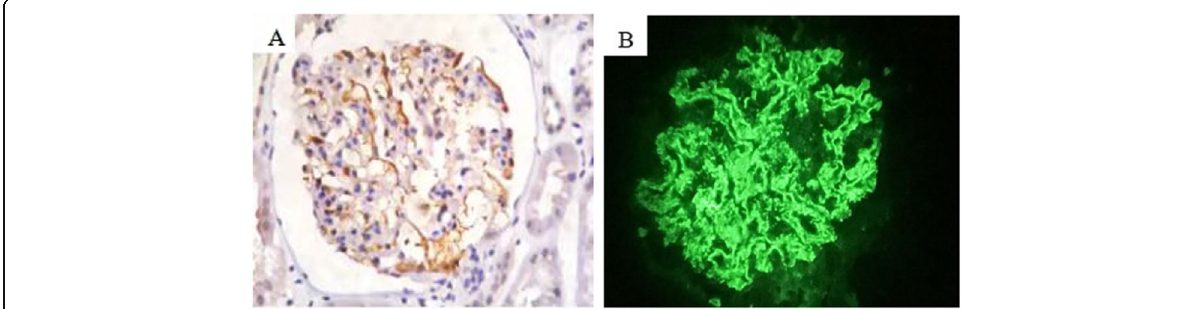
Fig. 1 A The immunohistochemical staining of HBcAg was positive, and the brown-yellow granules were distributed along the capillary wall of the glomerulus. IHC, 400×. B IgG deposits along the glomerular capillary wall and mesangial area, Immunofluorescence,